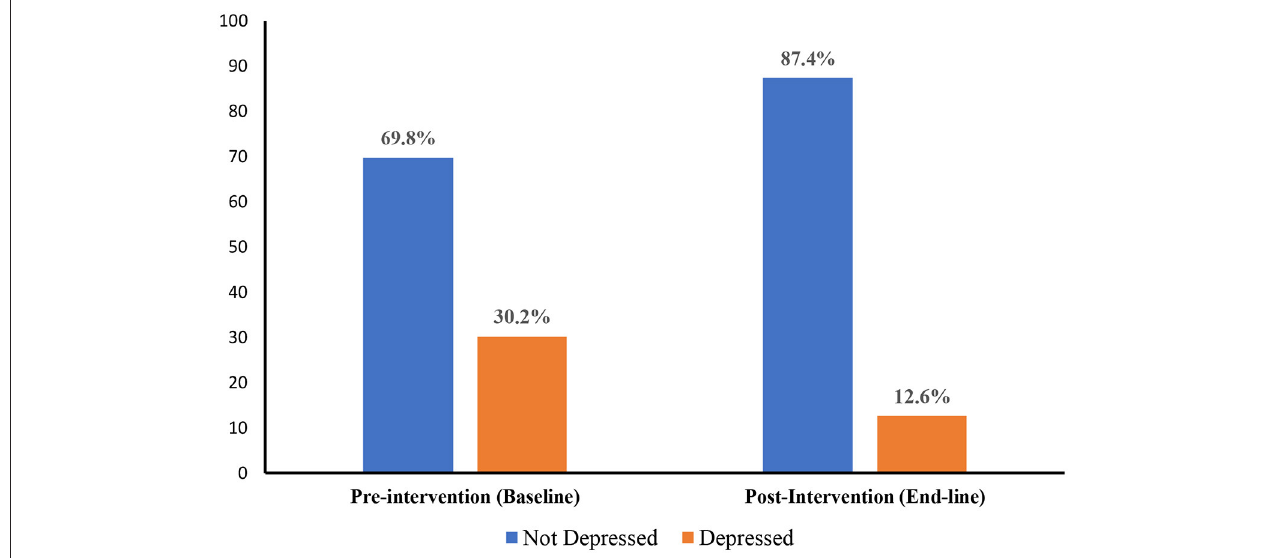
FIGURE 2 | Prevalence of reported feelings of depression among employees in the pre-intervention (baseline) and post-intervention (end-line) surveys.